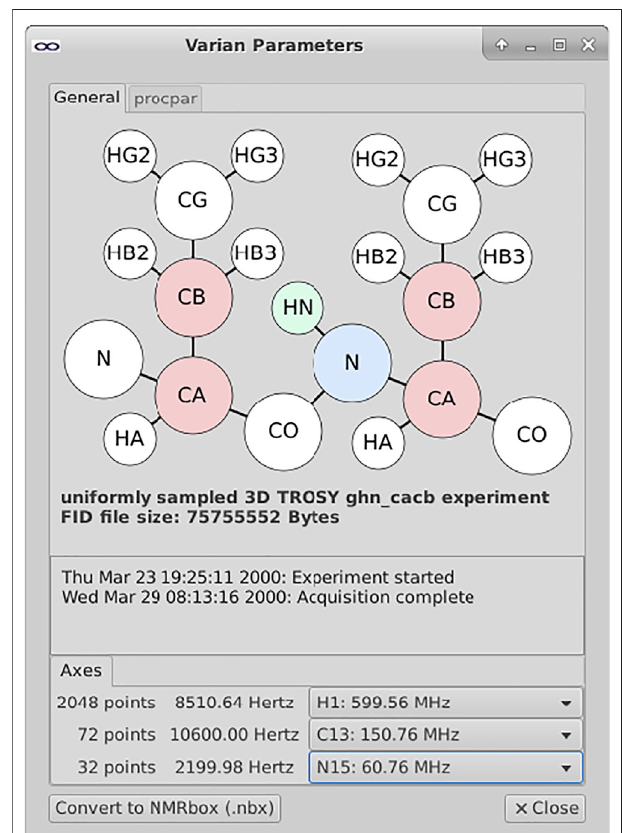
FIGURE3| MetadatawidgetforexploringVarian/AgilentNMRdatasets. The metadata widget shown above parses and extracts metadata from the various fi les within a Varian data directory. This data is used to construct a visual representation of the information layout of the data in terms of the protein atom types correlated along the various spectral dimensions. The mapping between spectral dimensions and axes are not unambiguously de fi nedwithinthespectrometermetadata;theuserisprovidedwithpull-down menus for documenting these